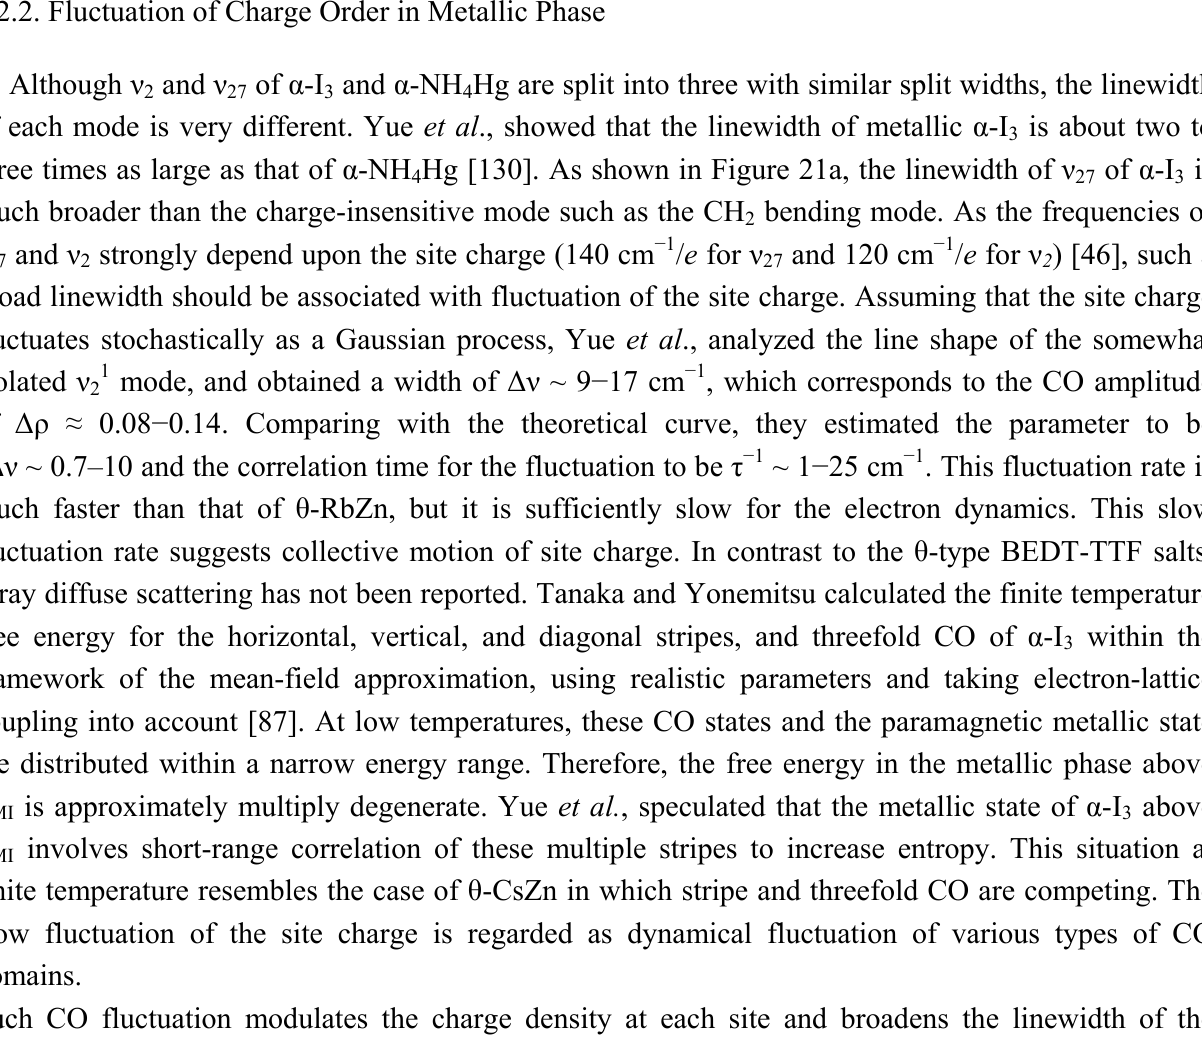
and ν 23 of α -(BEDT-TTF) I . ( a ) Temperature dependence 27 2 3 , which becomes very broad in the metallic phase; 27